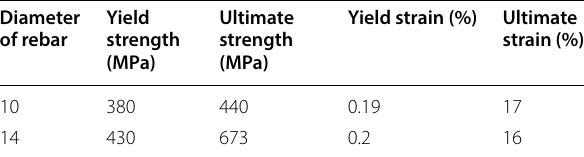
Table 6 Properties of applied